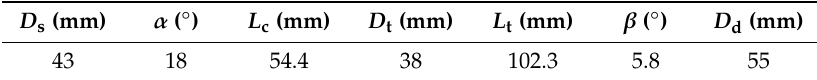
Table 1. Dimensions of the EAJP.